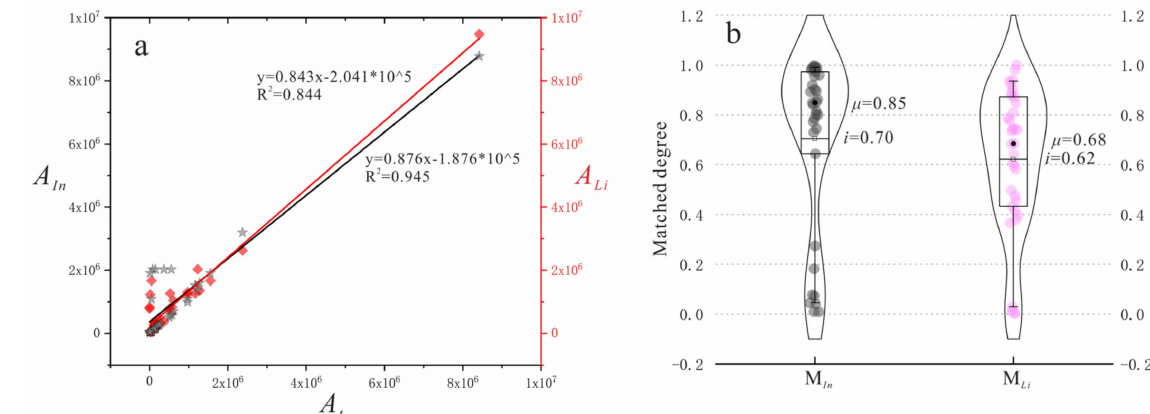
Figure 8. Comparison of InSAR-based and LiDAR-based landslides: ( a ) relationships between areas of InSAR-based and LiDAR-based landslides and the common area; ( b ) the matching degrees between the landslide identification results and the corresponding technical